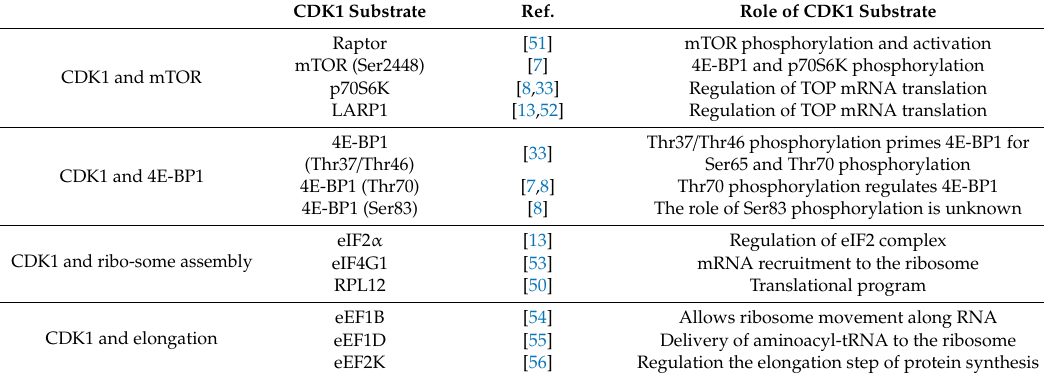
Table 1. Known cyclin dependent kinase 1 (CDK1) substrates involved in translation. CDK1 controls the phosphorylation status and activity of proteins involved in the initiation (mammalian target of rapamycin (mTOR), eukaryotic translation initiation factor 4E (eIF4E)-binding protein 1 (4E-BP1), ribosomal protein S6 kinase B1 (p70S6K)) and elongation (eukaryotic elongation factor 2 kinase (eEF2K)) steps of mRNA